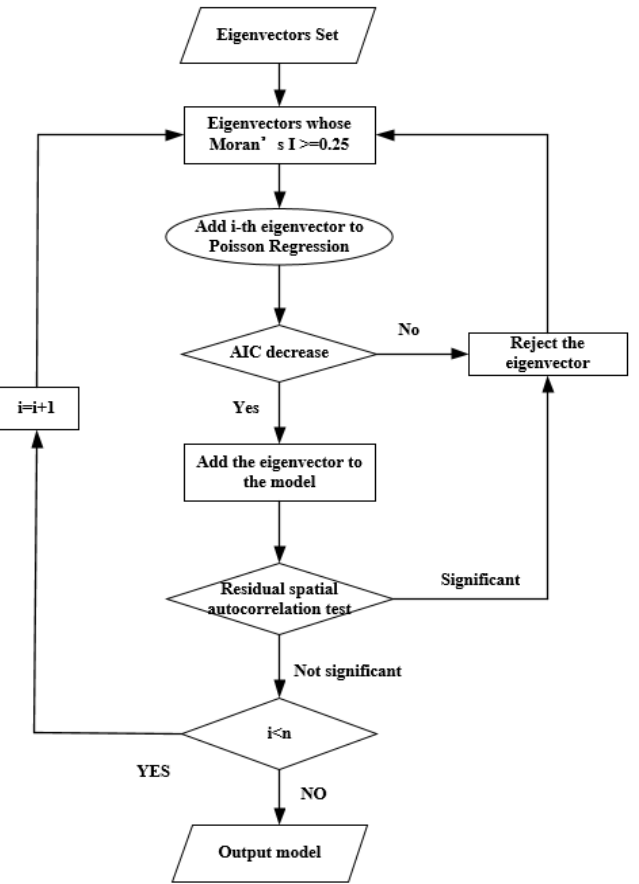
Figure 16. Flowchart of eigenvector selection.